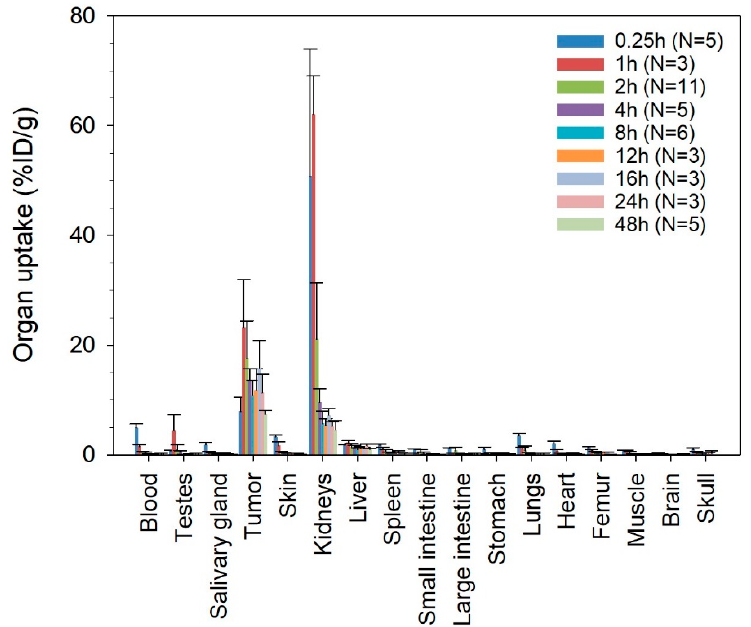
Figure 2. Decay-corrected percentage of injected activity per gram of tissue (%ID/g) ± SD of 212 Pb- NG001 in athymic nude mice bearing human prostate C4-2 cancer xenografts at various time points after injection. N, number of mice per group.